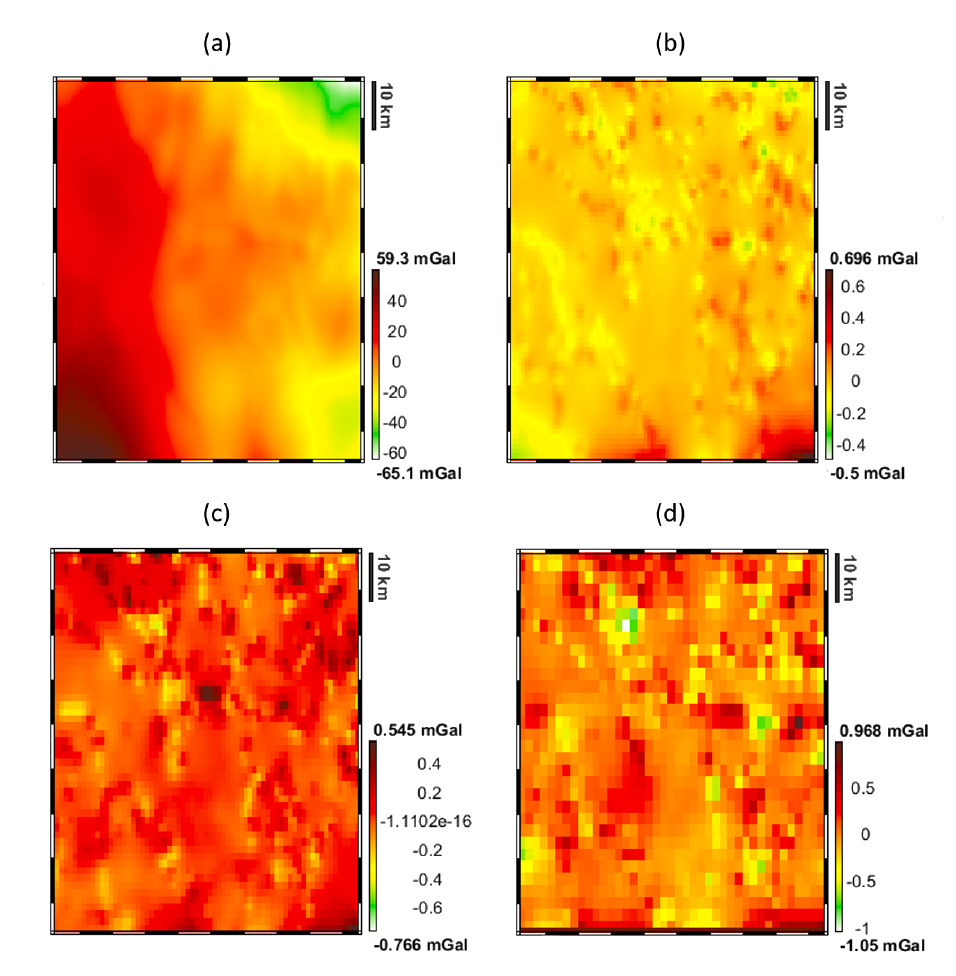
Figure 6. Signal due to the a-priori model with 500 m resolution ( a ); its differences with respect to the signal generated from the 1000 m resolution ( b ), 1500 m resolution ( c ) and 2500 resolution ( d )